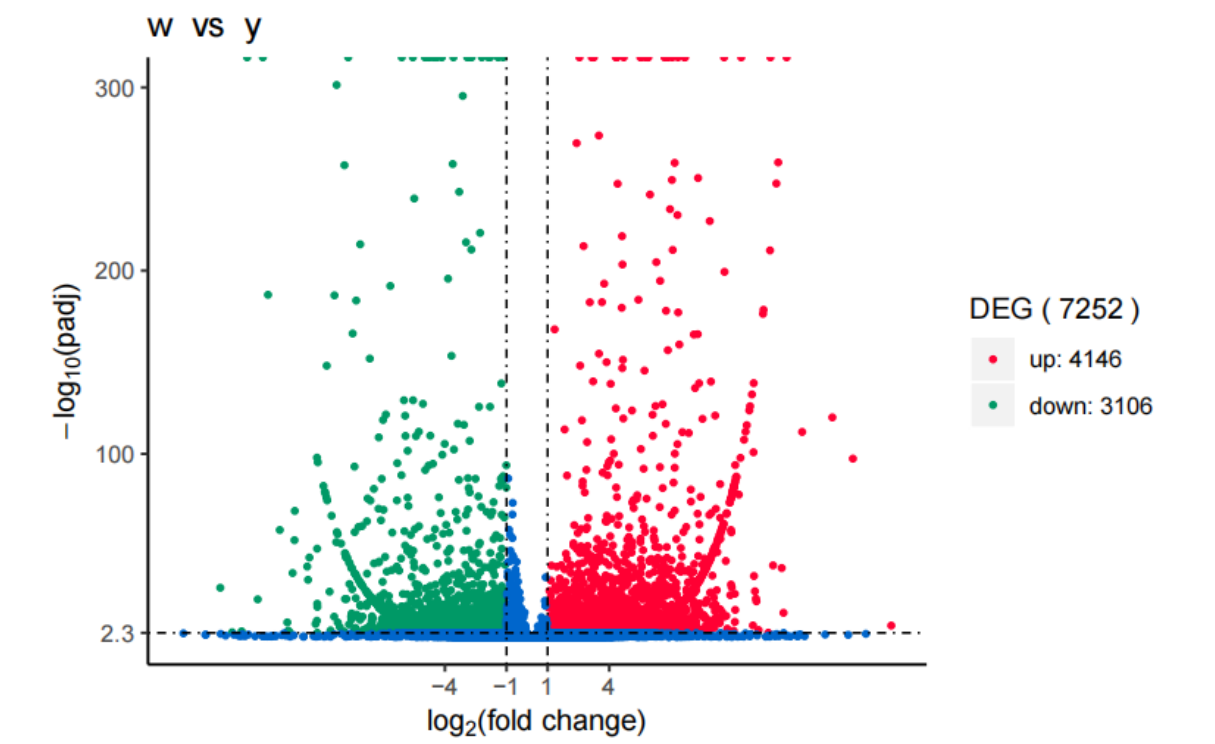
Figure 9. Gene expression differences between wild-type and domesticated Daphniopsis tibetana .